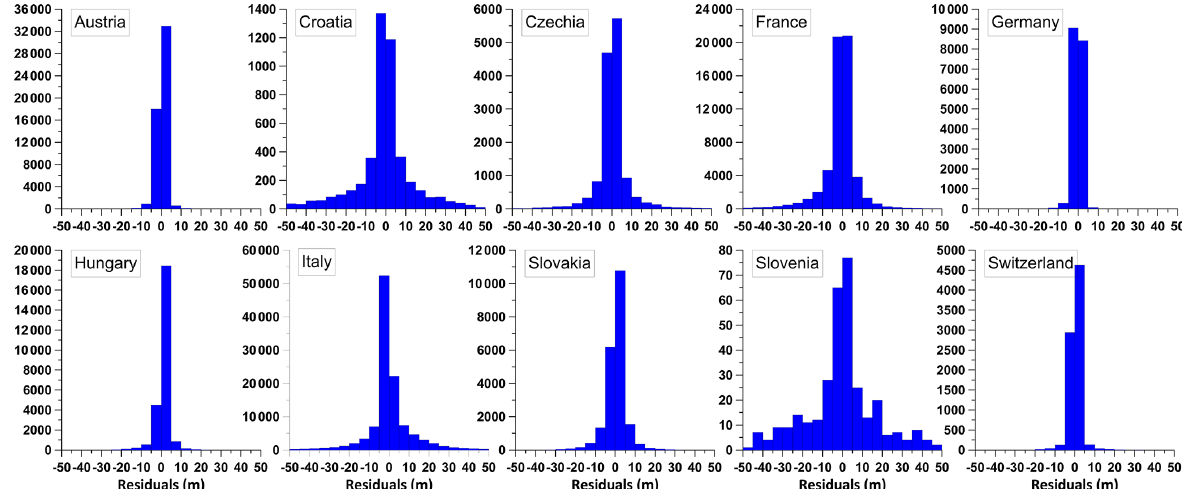
Figure C2. Histograms of height difference residuals of participating countries. The values in the different classes are given in meters.